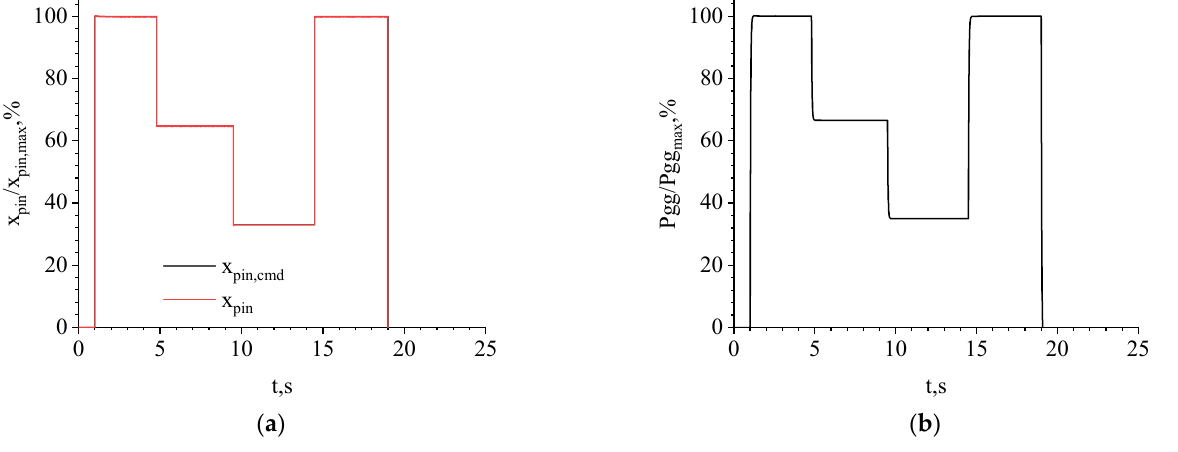
Figure 6. Simulation results of the control system based on displacement closed-loop control. ( a ) Displacement instruction and tracking results. ( b ) Chamber pressure control results.